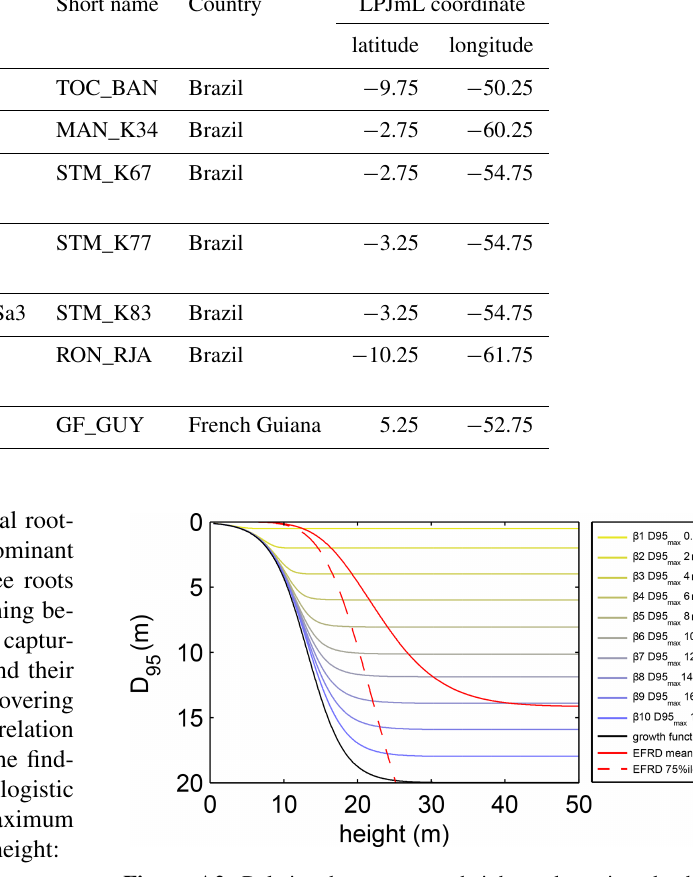
Figure A2. Relation between tree height and rooting depth in LPJmL4.0-VR. Black line: implemented general growth function of rooting depth (Eq. A5). Lines with colour scale from yellow to blue: growth functions of rooting depth for each of the 10 sub- PFTs (Sect. 2.2.3). Here temporal rooting depth is expressed as D 95 and eventually reaches D 95_max (Eq. A3). Solid red line: mean ef- fective functional rooting depth over tree height (EFRD) adapted from Brum et al. (2019) using Eq. (A5). Dashed red line: respec- tive 75th-percentile EFRD over tree height adapted from Brum et al. (2019). Please also see Supplementary Video 1 for a visual- ization of root growth and development of below-ground carbon pools over time available at http://www.pik-potsdam.de/~borissa/